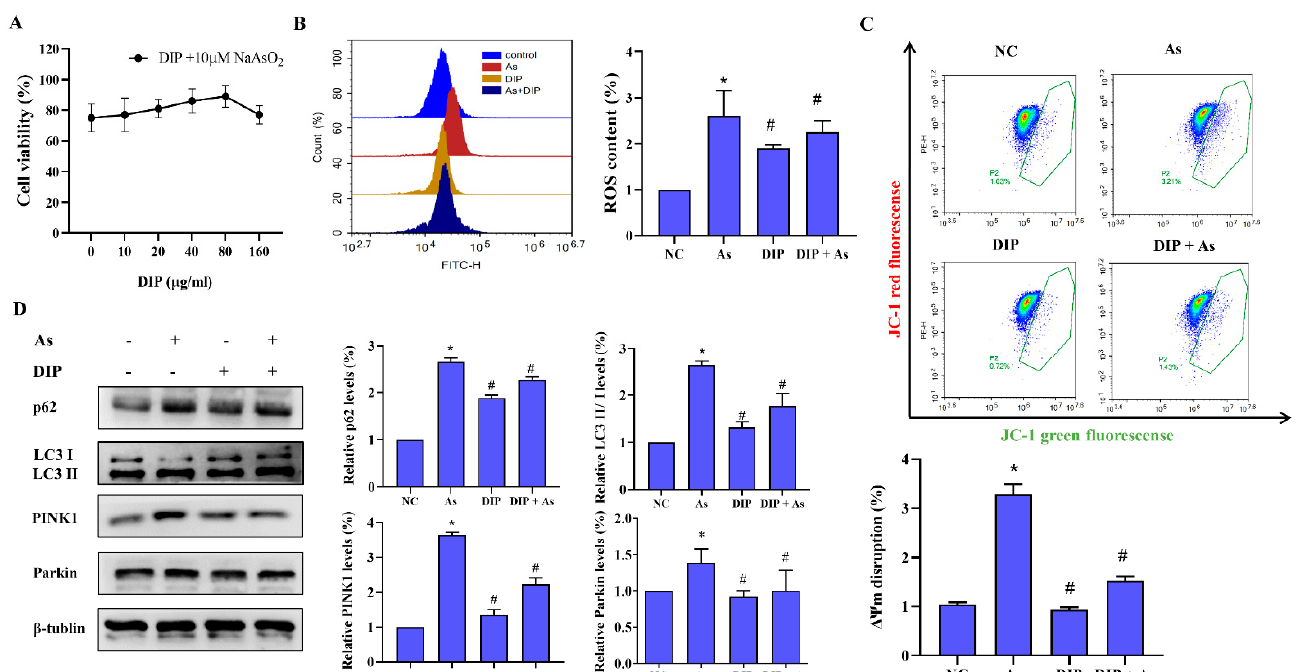
Figure 2. DIP inhibited NaAsO2-induced mitophagy in L-02 cells. ( A ) CCK8 assay was used to determine the concentration of DIP with the best effect. ( B ) DCFH-DA fluorescent probe was used to detect intracellular ROS. ( C ) JC-1 mitochondrial membrane potential detection kit was used to detect mitochondrial membrane potential of cells. ( D ) Western blotting was used to detect the effect of DIP on autophagy-related proteins. * p < 0.05 compared with the control group. # p < 0.05 compared with the As group.